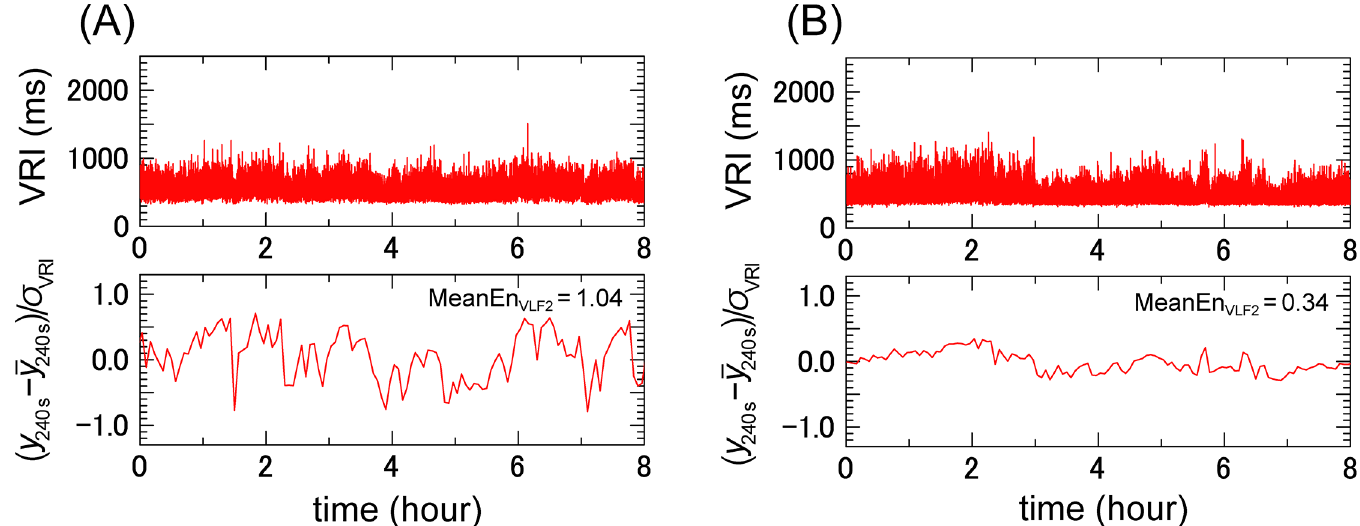
Fig 2. Ventricular response interval and its coarse-grained time series in patients with and without ischemic strokes. (A) A 75-year-old male had an ischemic stroke at 2 months after the recording. (B) A 45-year-old male who did not experience an ischemic stroke during 95 months after the recording. The VRI (upper panel) and its coarse-grained time series with a 240 sec (4 min) scale (lower panel) are shown. The coarse-grained time series is rescaled by subtracting its mean and dividing the differences by the SD ( δ ) of the VRI time series. VRI: ventricular response interval, MeanEn VLF2 : mean value of sample entropy of the very-low frequency range 2 (90 – 300